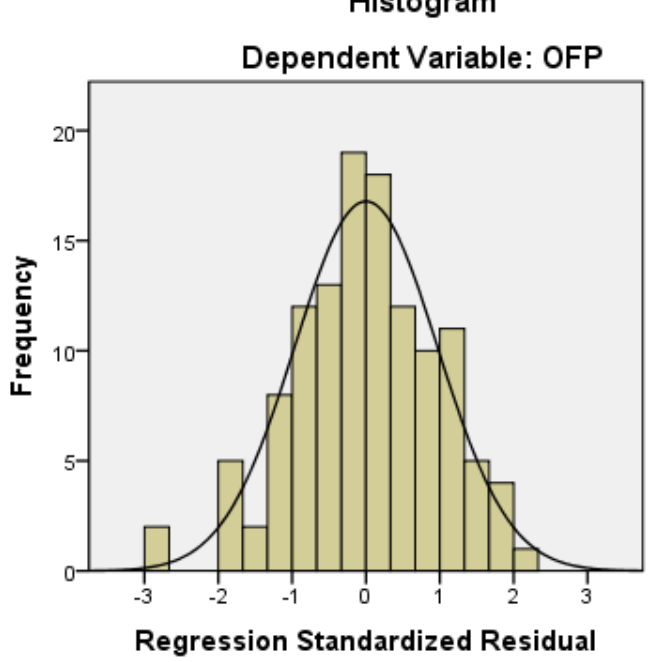
Figure A3. Histogram demonstrating the distribution of values of the residuals. Notes: Mean = 1.40 × 10 − 14 , Std. Dev. = 0.999, N = 122. Source: Compiled by the Authors. ——————————————————————————————————————— --------------------------------------------------------------------------------------------------------------------- Cook’s Distance approach to estimate the effect of influential data points which produce model’s bias. A regression analysis uses Cook’s distance to detect significant outliers from a group of predictor variables. The obtained Cook’s Distance values are all under 1 in our study disclose that individual cases are not unduly influencing the model. In other words, there are no influence cases biasing the model.